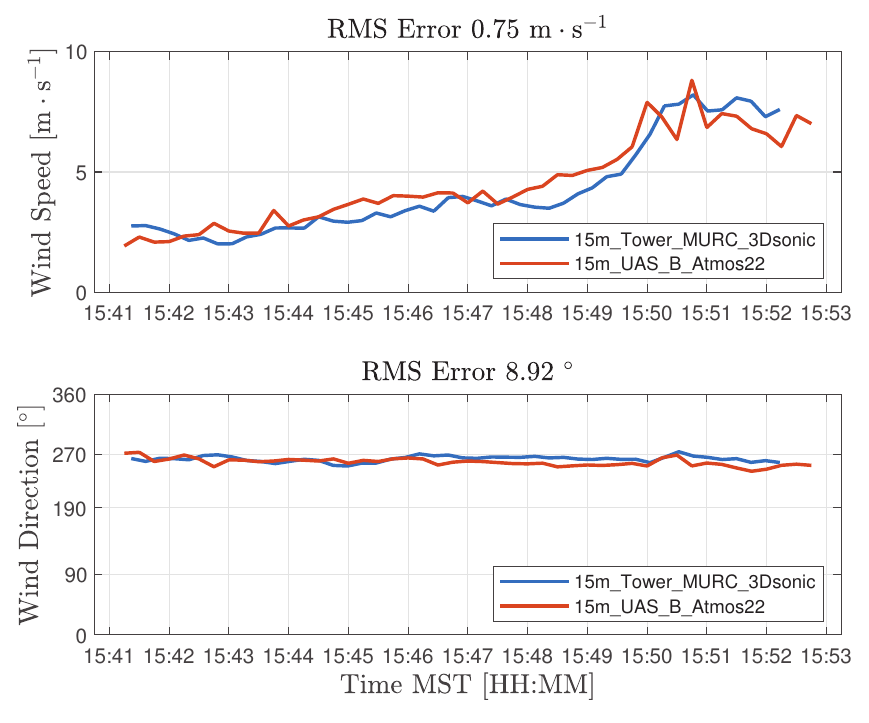
Figure 8. Root-mean-square (RMS) error comparison for wind speed and direction measurements collected from UAS B and MURC Tower at 15 meters above ground